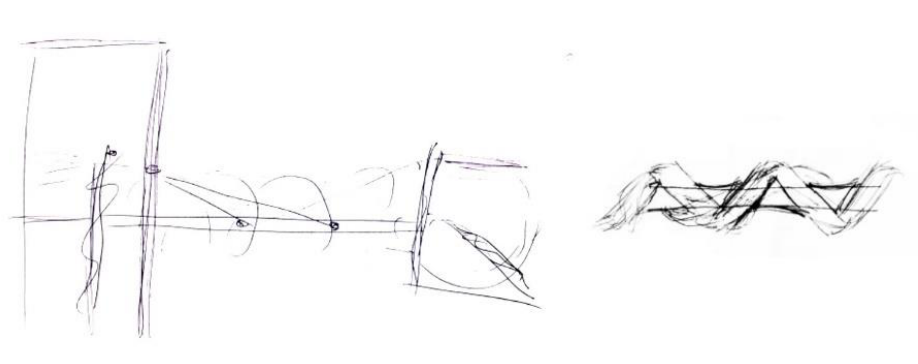
Fig. 10 First design sketch of the bridge “Wrapping”.